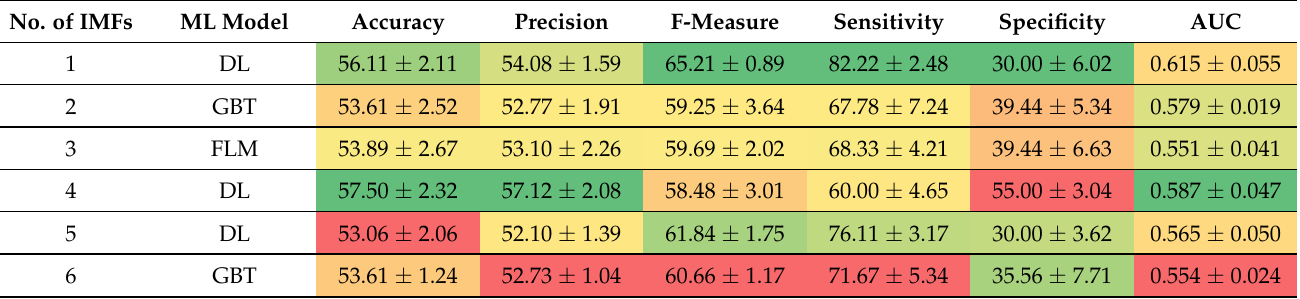
Table 1. Classification performance of the best ML models generated from the EMD-based processing of the ECG signals at different decomposition